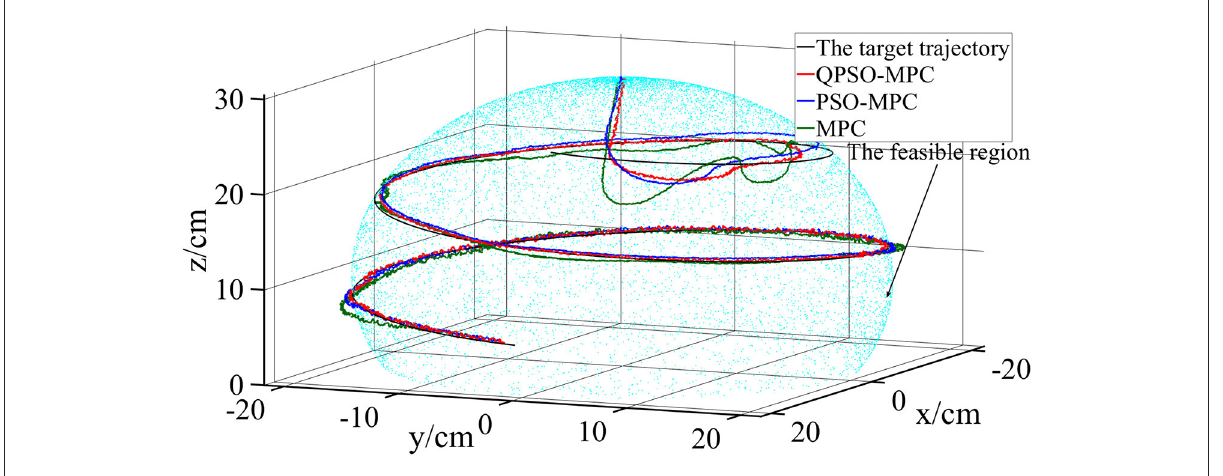
FIGURE12 Experiment results of the spiral trajectory